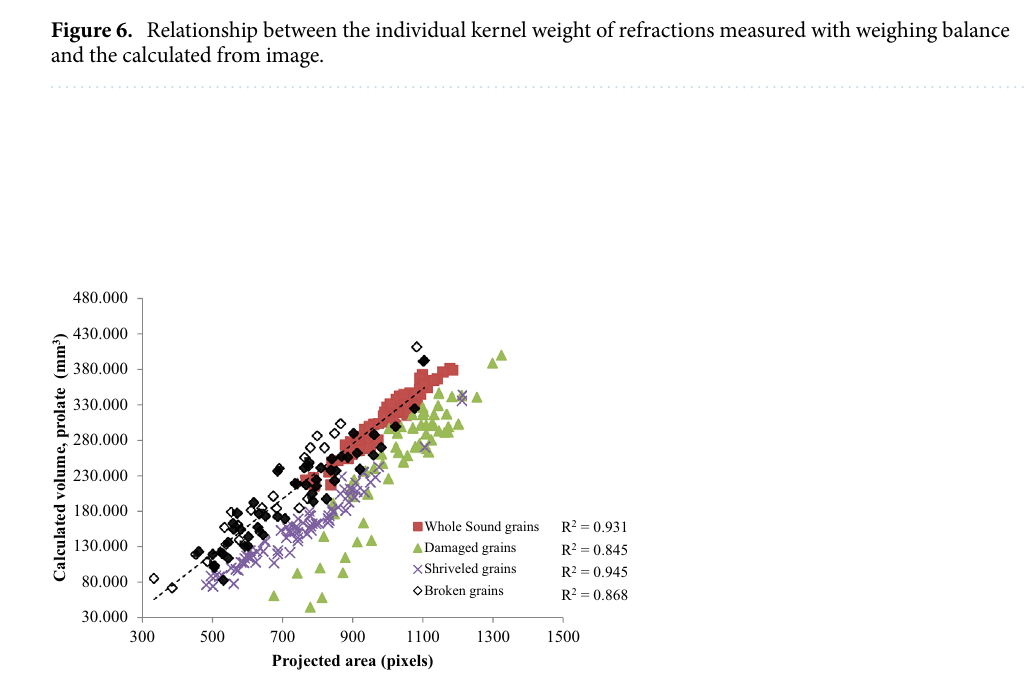
Figure 7. Relationship between the volume of refractions derived from measured dimensions and the calculated from